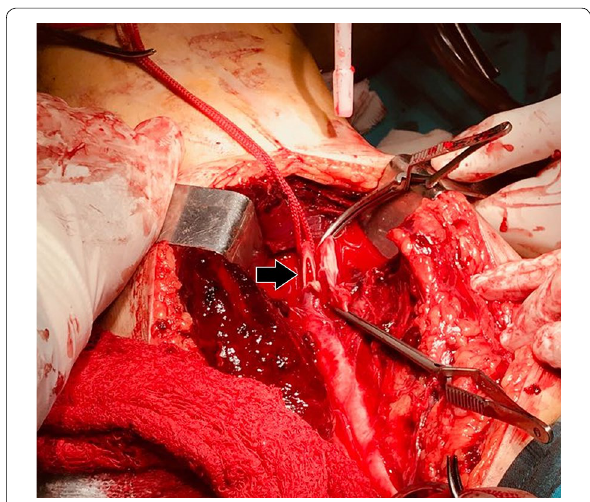
Fig. 2 Surgery demonstrating a 1-cm laceration in the anterior aspect of the superficial femoral artery